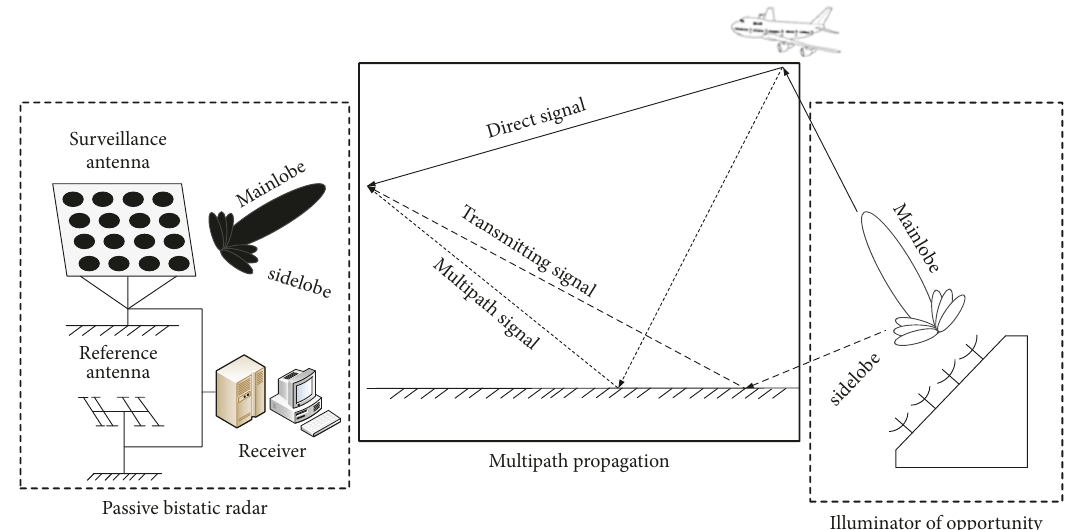
Figure 1: Basic operating scenario of PBR